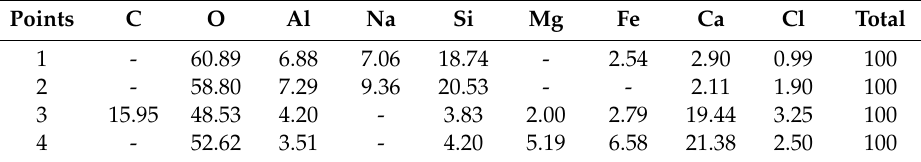
Table 2. EDS spectrum of the samples exposed to NaCl at 3.5.